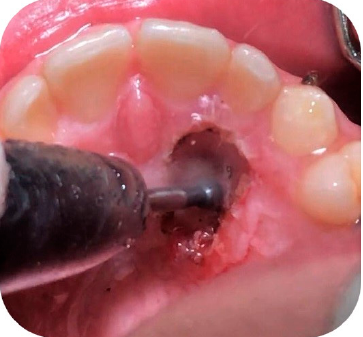
Figure 5. Osteotomy through a handpiece at low speed with a rosette bur by ISO 018 diameter (Maillefer ® , Ecublens, Switzerland).